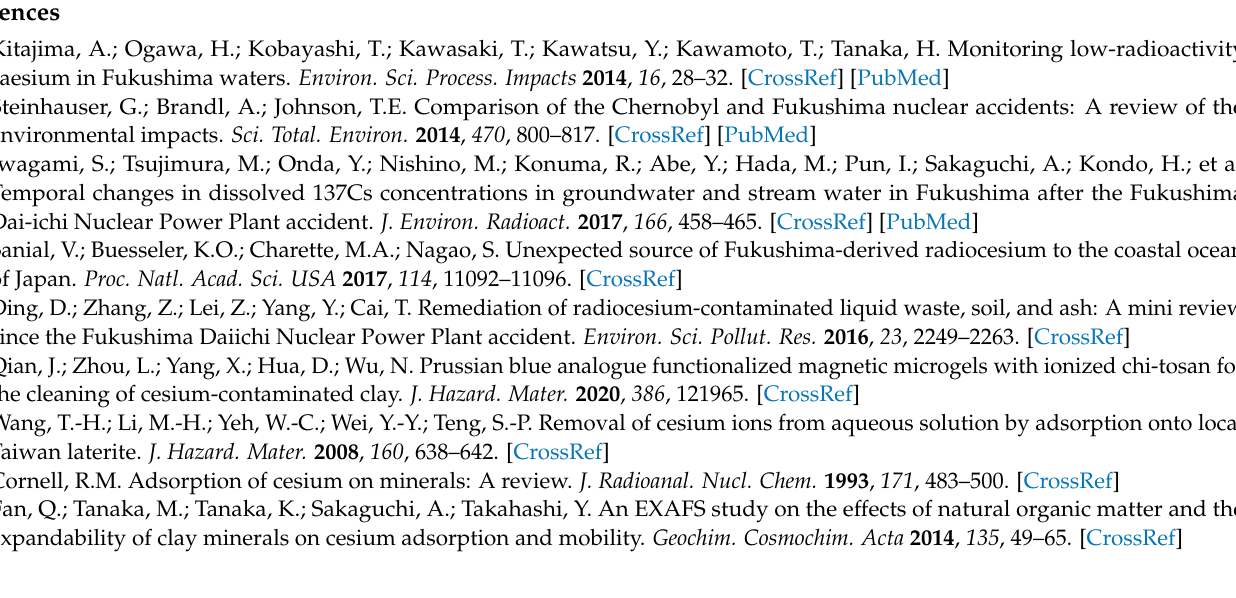
Figure S2: X-ray diffraction patterns of YC1 (a) before and (b) after ethylene glycol treatment. Black solid arrow shows that I/S peak migrated to low theta position due to expanding interlayer by ethylene glycol treatment. (I: illite, I/S: illite-smectite, Q: quartz, A: albite). Figure S3: Cesium uptake kinetics of MI and CI at C i = 1 × 10 µ g L − 1 , and pseudo-second-order (PSO) kinetic curve. Table S1: Results of XRF analysis for clay samples. Table S2. Distribution coefficients ( K d , L kg − 1 ) of samples at various C w , respectively. Table S3: The mineral contents after quantification of HCI and LCI